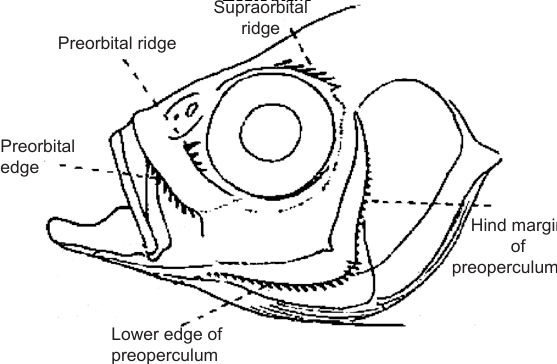
Figure 1. Cephalic serration of Parambassis waikhomi , 36.3mm SL